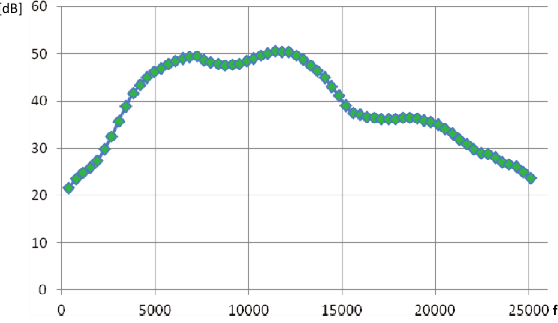
Fig. 6. Mean spectral density values for the new injector